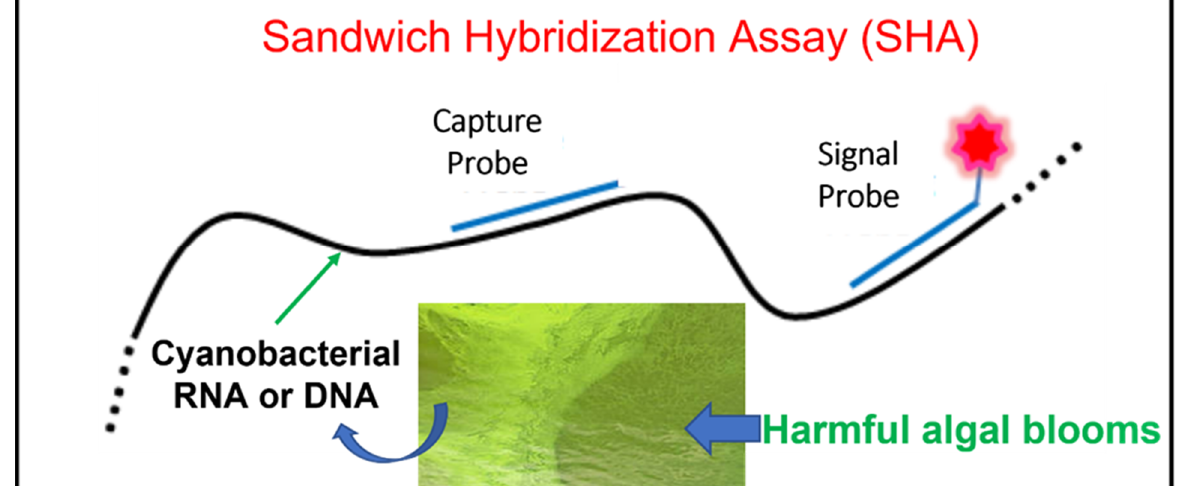
Figure 1. Schematic representation of sandwich hybridization assay (SHA) application to detection of harmful algal blooms-forming cyanobacteria. A target cyanobacterial nucleic acid molecule is “sandwiched” between a capture oligonucleotide probe immobilized on a solid support and a signal oligonucleotide probe labeled with a detection marker.